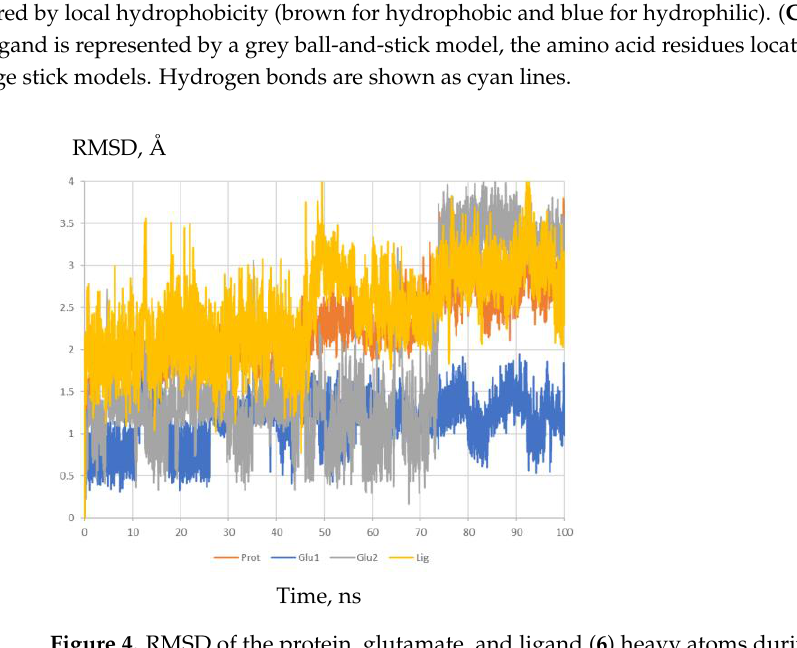
Figure 4. RMSD of the protein, glutamate, and ligand ( 6 ) heavy atoms during molecular dynamics simulation of the PAM complex with the dimeric ligand-binding domain of the GluA2 AMPA receptor.